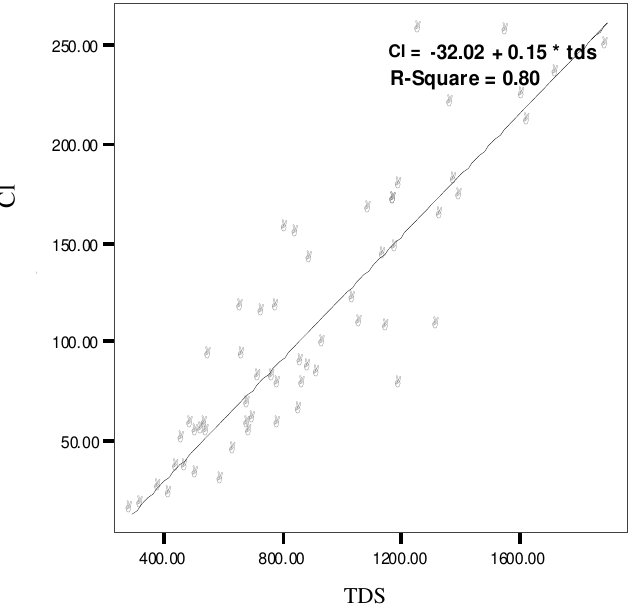
Figure 4. Correlation between total dissolved solids and